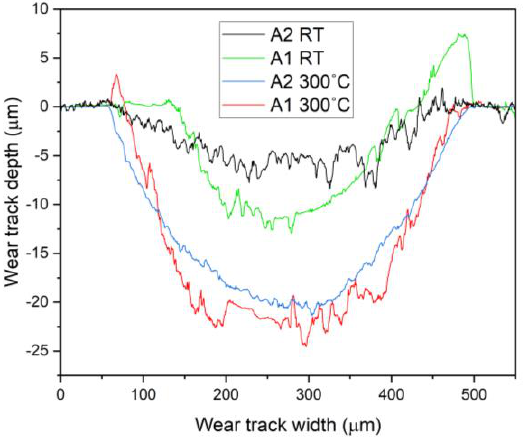
Figure 3. Representative cross-sectional wear track depths and widths of A1 and A2 alloys after RT and 300 °C sliding.